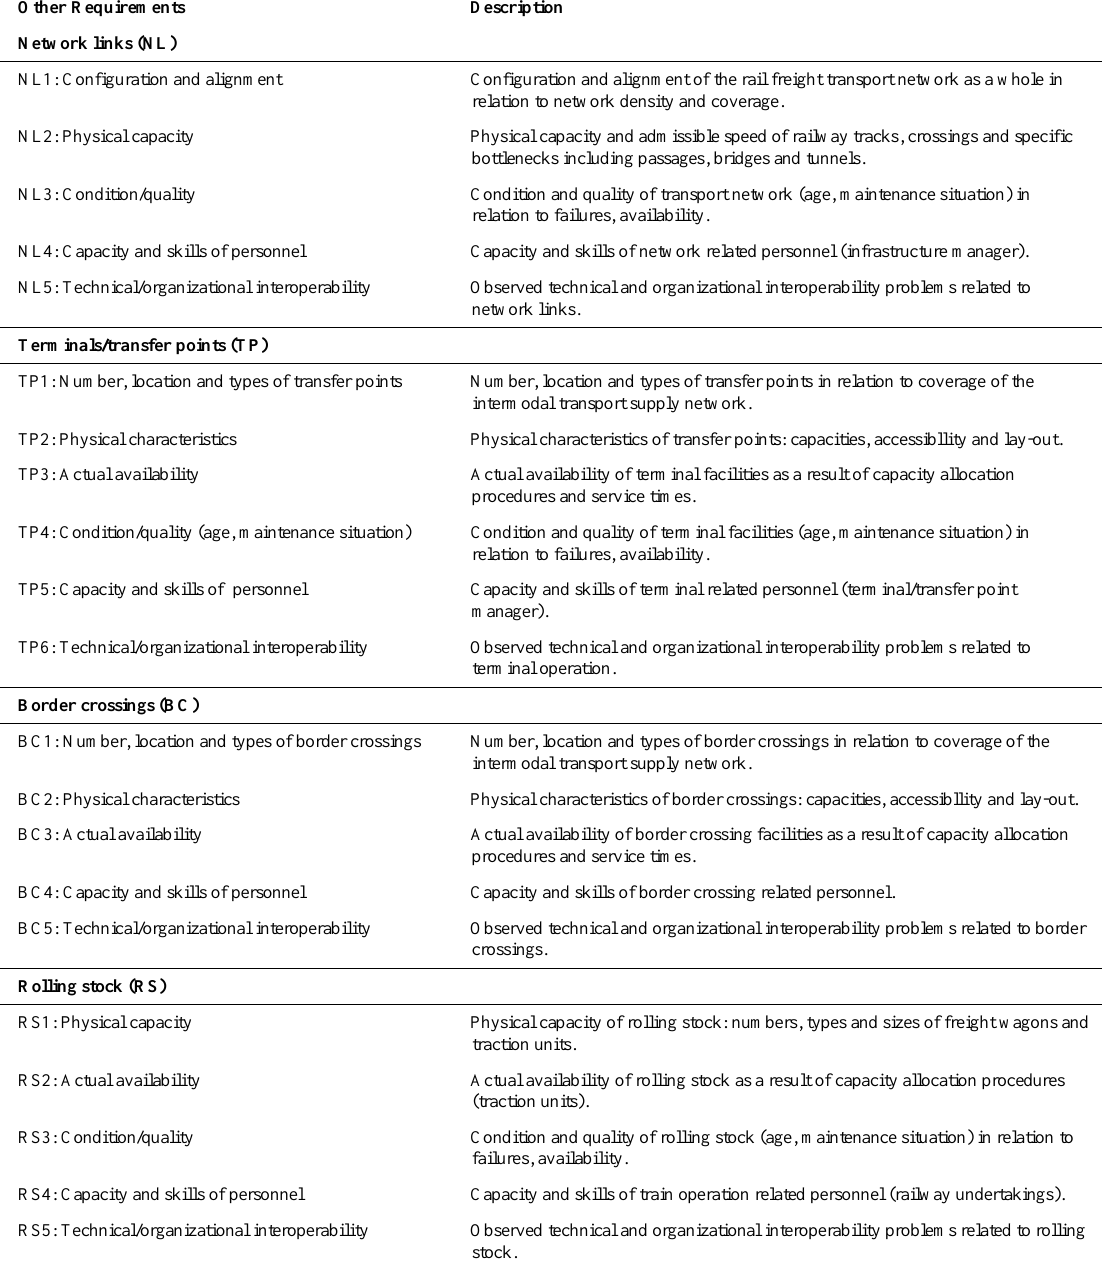
Table 2. Other requirements to achieve seamless rail freight transport Other